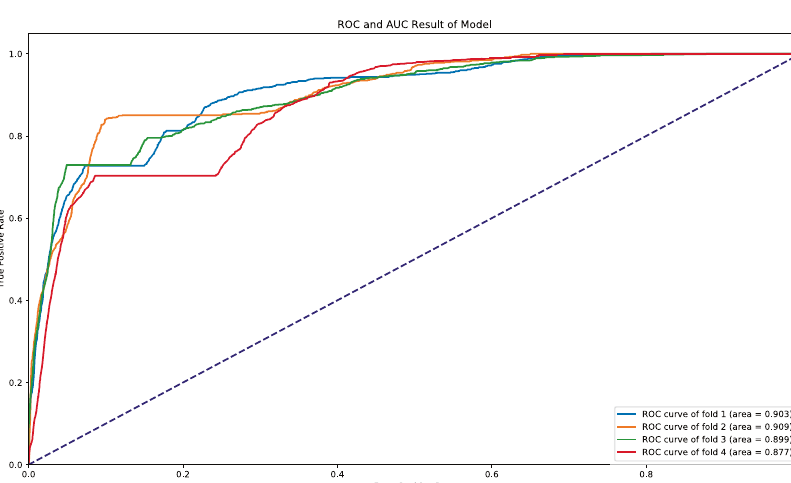
Fig. 2 The ROC curve and AUC of our fi nal model on the four validation sets. The mean AUC of the model is 0.897. The plot of predictions for each infant in four validation sets are shown in Supplemental Figs. 1 –